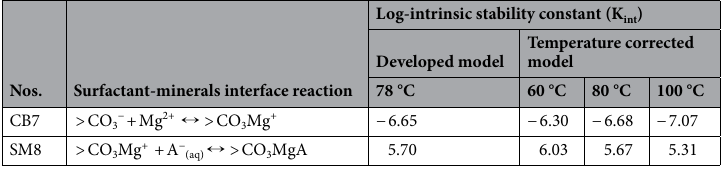
Table 7. Magnesium surface complexation reactions added for better experimental data match.